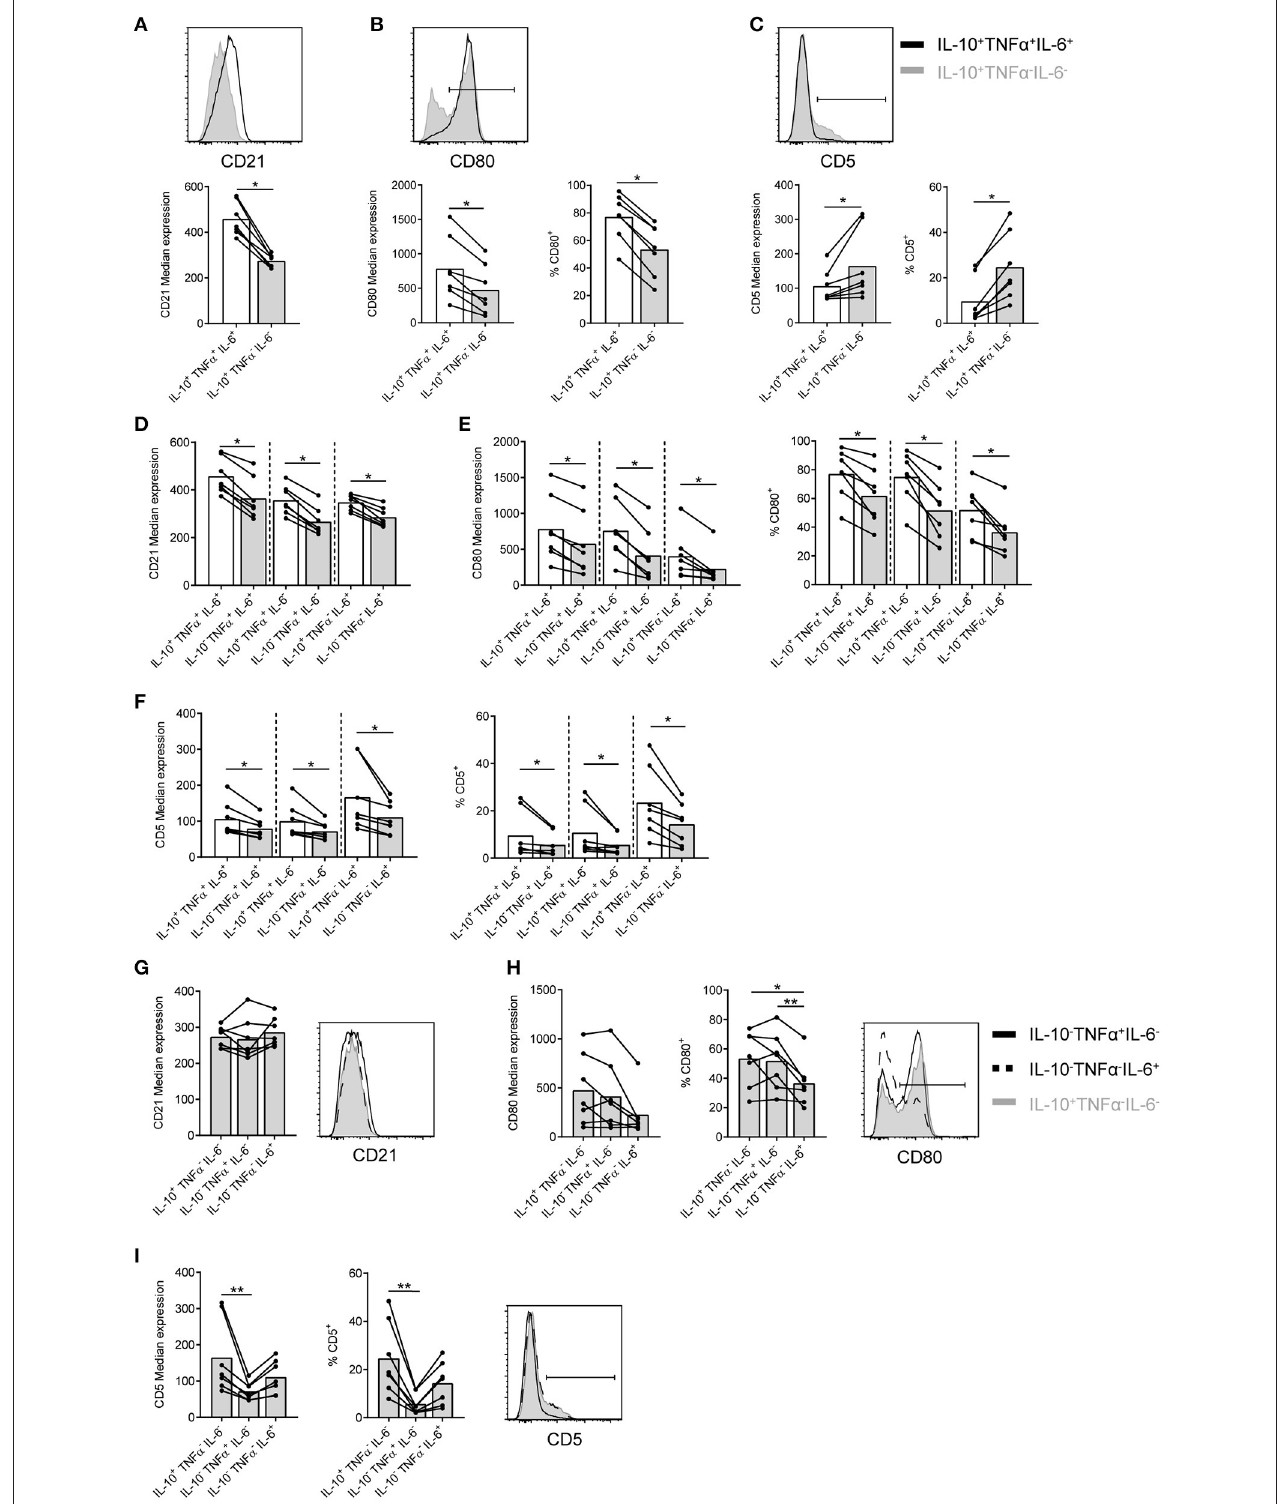
FIGURE 5 | CD21, CD80, and CD5 are not unique markers for CpG-induced IL-10 + TNF α − IL-6 − B cells. Total CD19 + B cells were isolated from blood and stimulated with CpG (1.25 µ M) for 2 days followed by restimulation with PMA/Ionomycin/BFA (PIB) ( n = 7). All live CD19 + cells were analyzed using flow